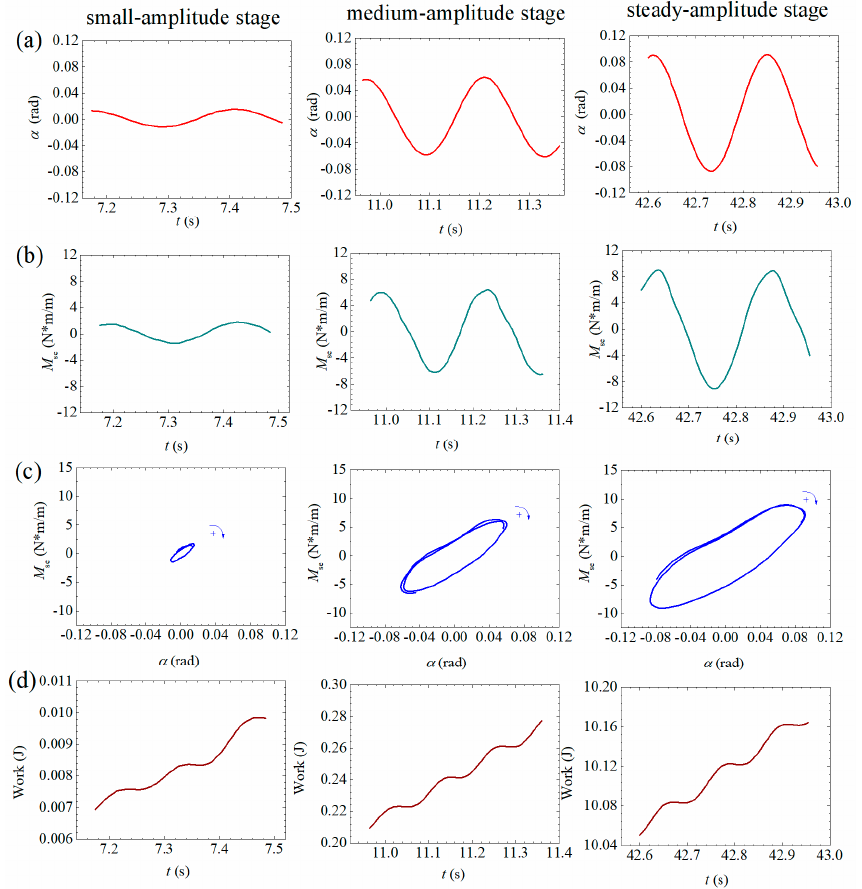
Figure 23. Evolutionary energy mechanism during a post-critical LCO in the torsional DOF (Case B1, U * = 7.785). ( a ) Torsional dispalcement; ( b ) measure of aerodynamic torsional moment; ( c ) hysteresis loops; ( d ) accumulative works.